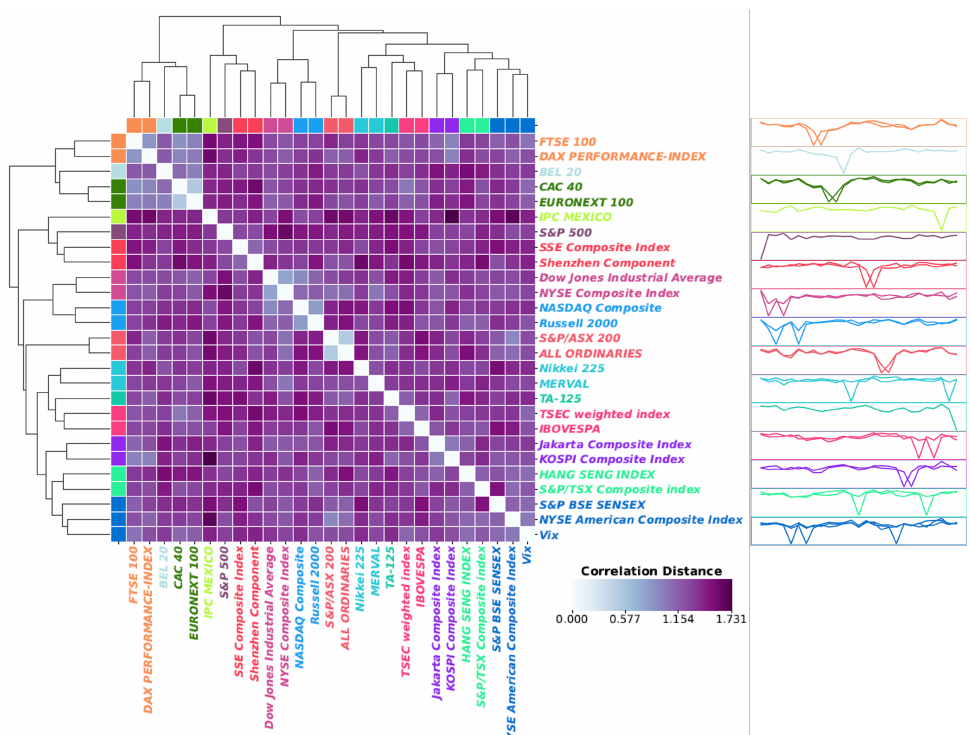
Figure 5. Long-term hierarchical clustering of informational efficiency patterns of 27 international markets. The colored squares below the dendrogram branches indicate the 15 clusters obtained by maximizing the silhouette